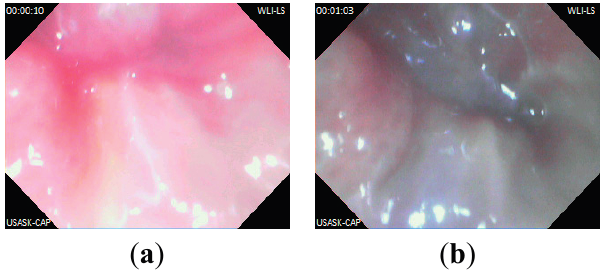
Figure 11. Captured lossless WLI images from pig’s intestine: ( a ) CR = 79.71%; ( b ) CR = 75.61%.